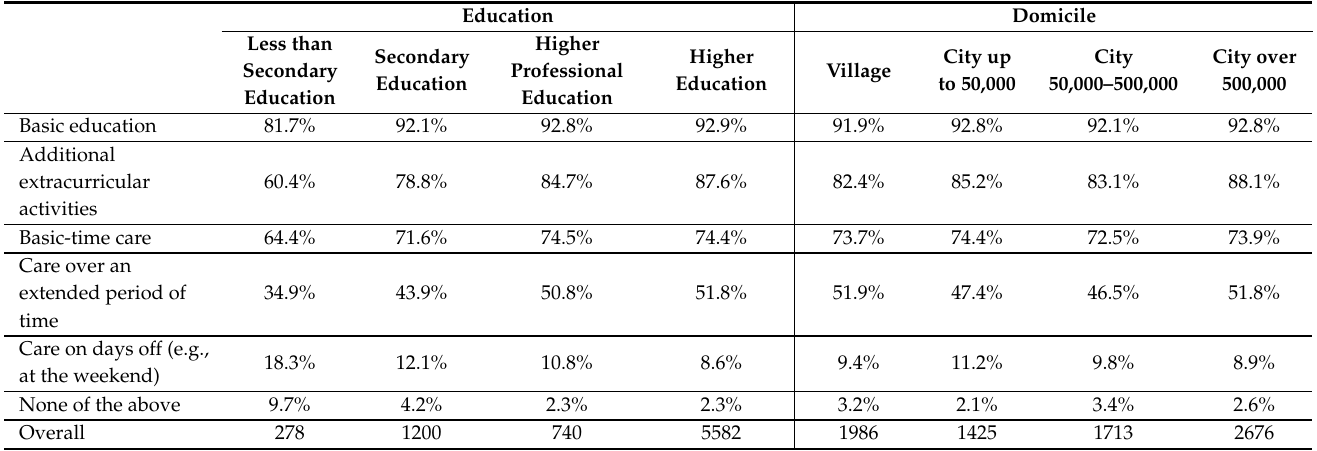
Table 5. Expected scope of activity of the school/facility (education and domicile) (n =